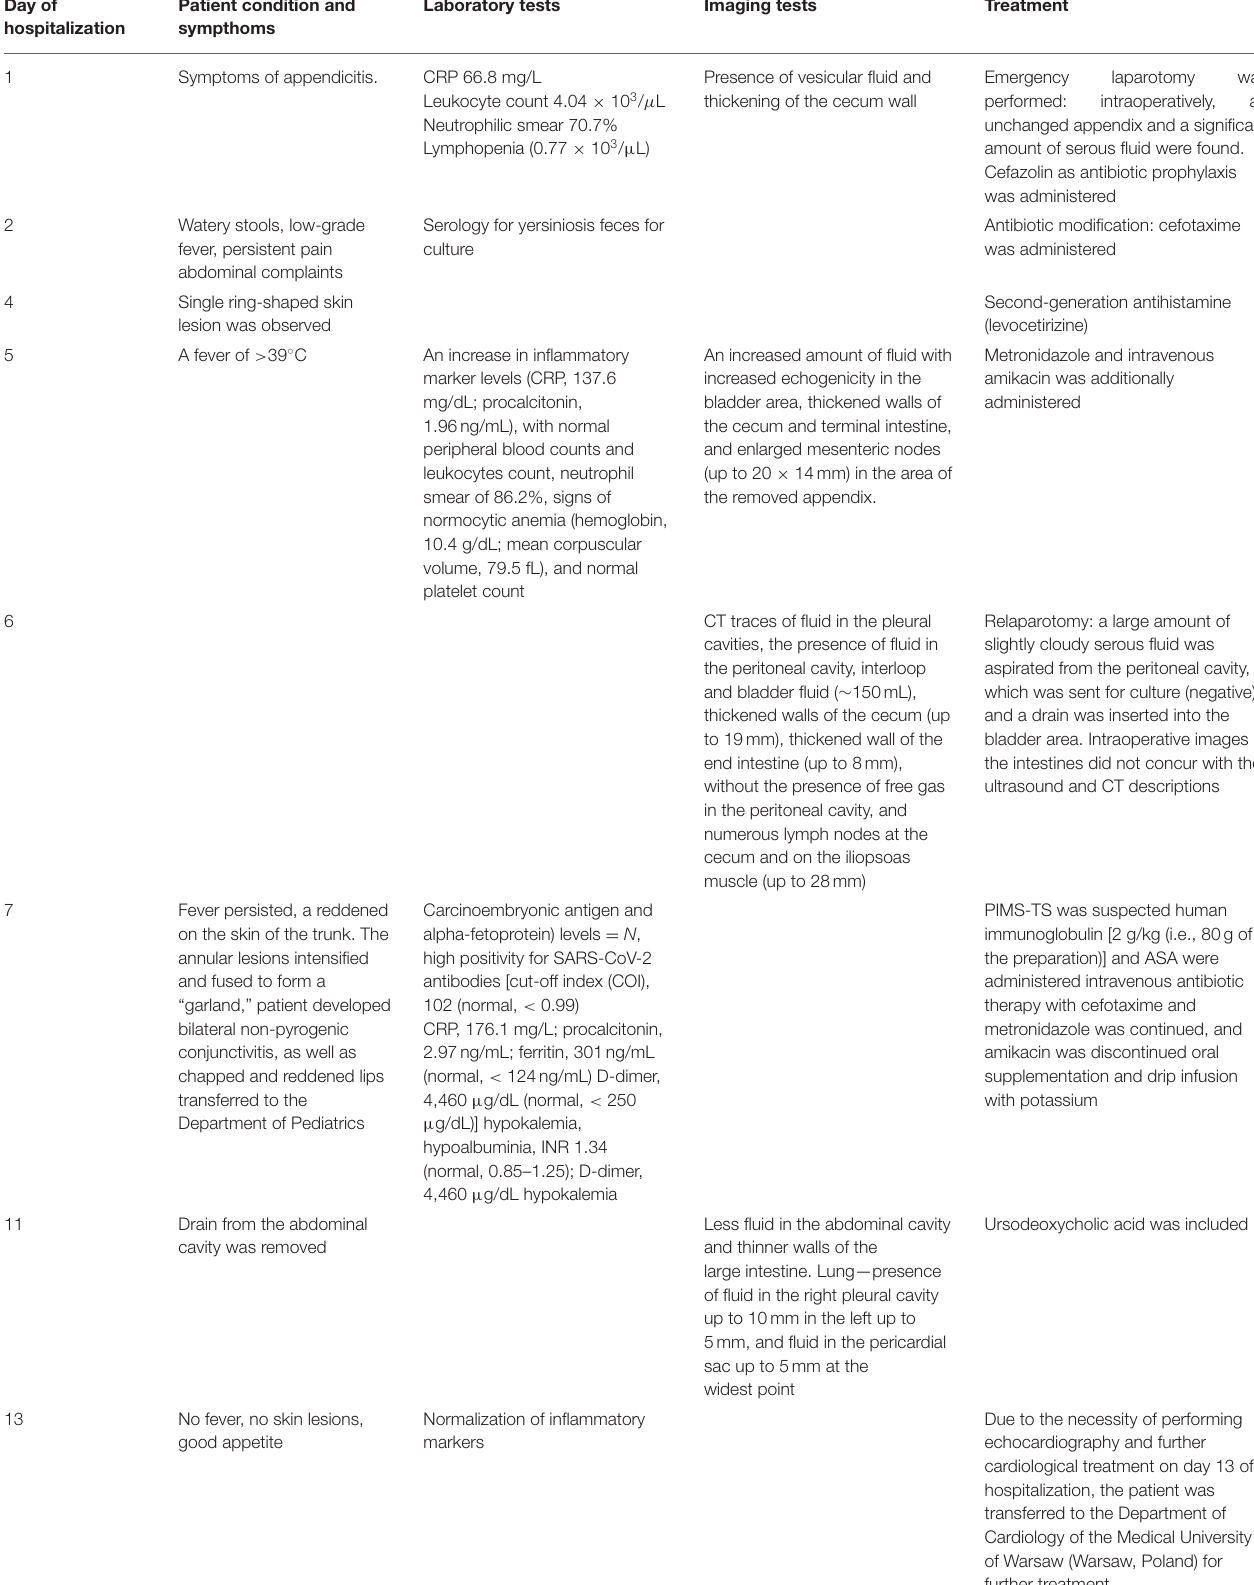
TABLE 2 | Patient’s hospitalization